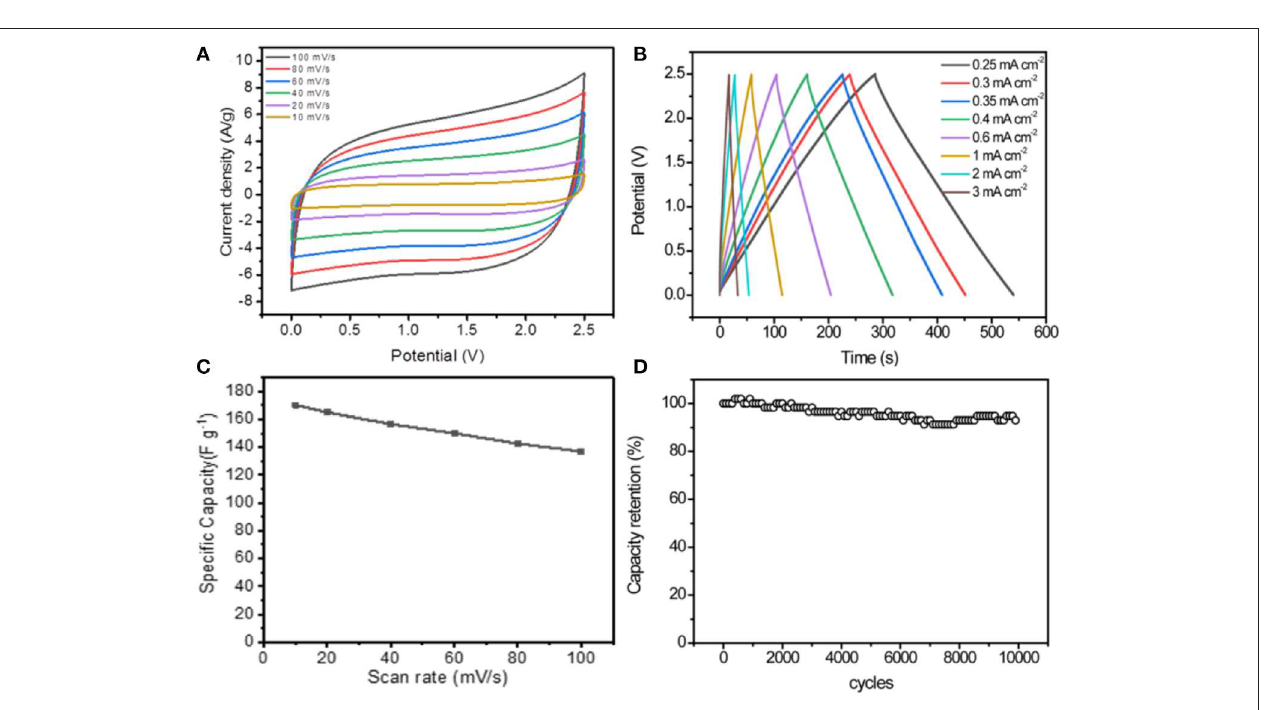
with the current density increase to 100 mV s − 1 ( Figure 3C